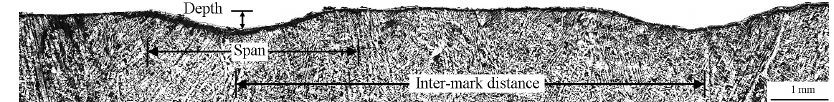
Figure 11. Two adjacent oscillation marks and typically observed microstructure underneath them.